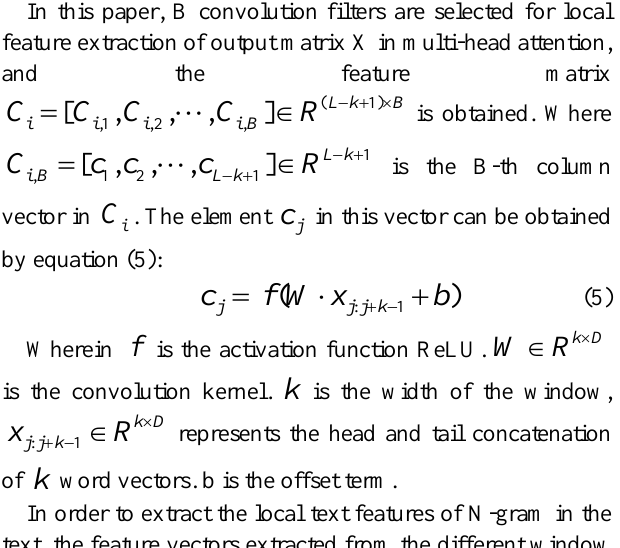
Figure 3. Schematic diagram of convolution